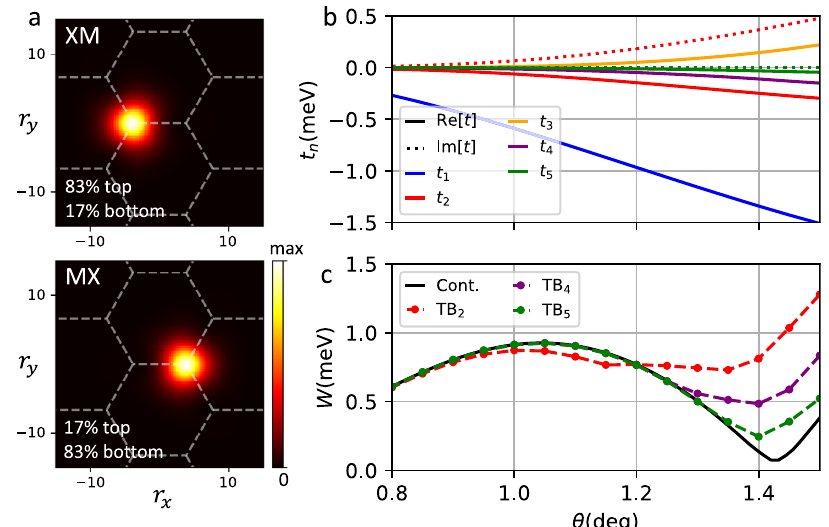
Fig. 4 Wannier functions and tight binding model parameters. a Wannier functions at the magic angle, b tight binding parameters as a function of θ , and c the bandwidth of the top band in the effective tight binding model TB n keeping up to n th nearest neighbor hopping terms, compared to that of the continuum